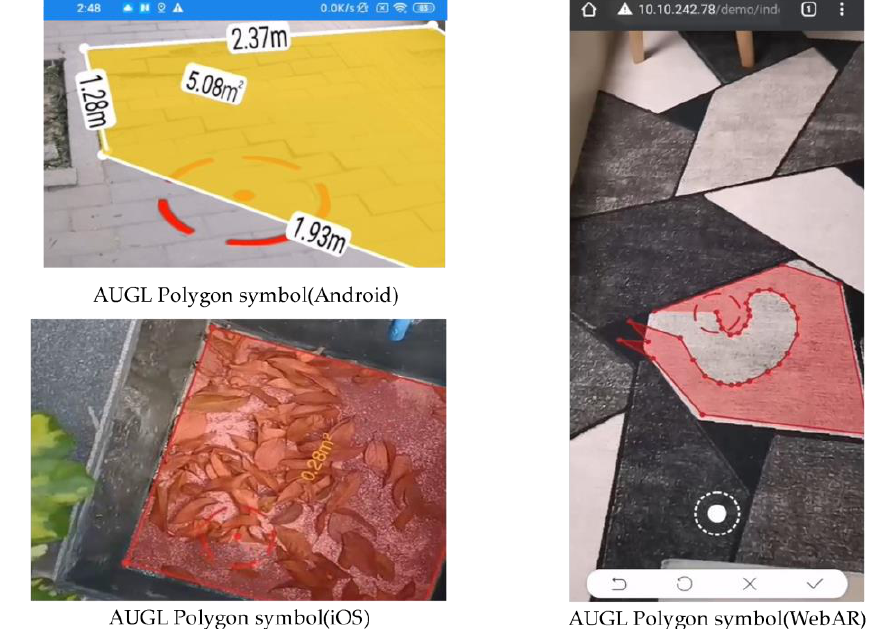
Figure 16. The polygon symbol algorithms are rendered consistently in three cross-platform envi- ronments.